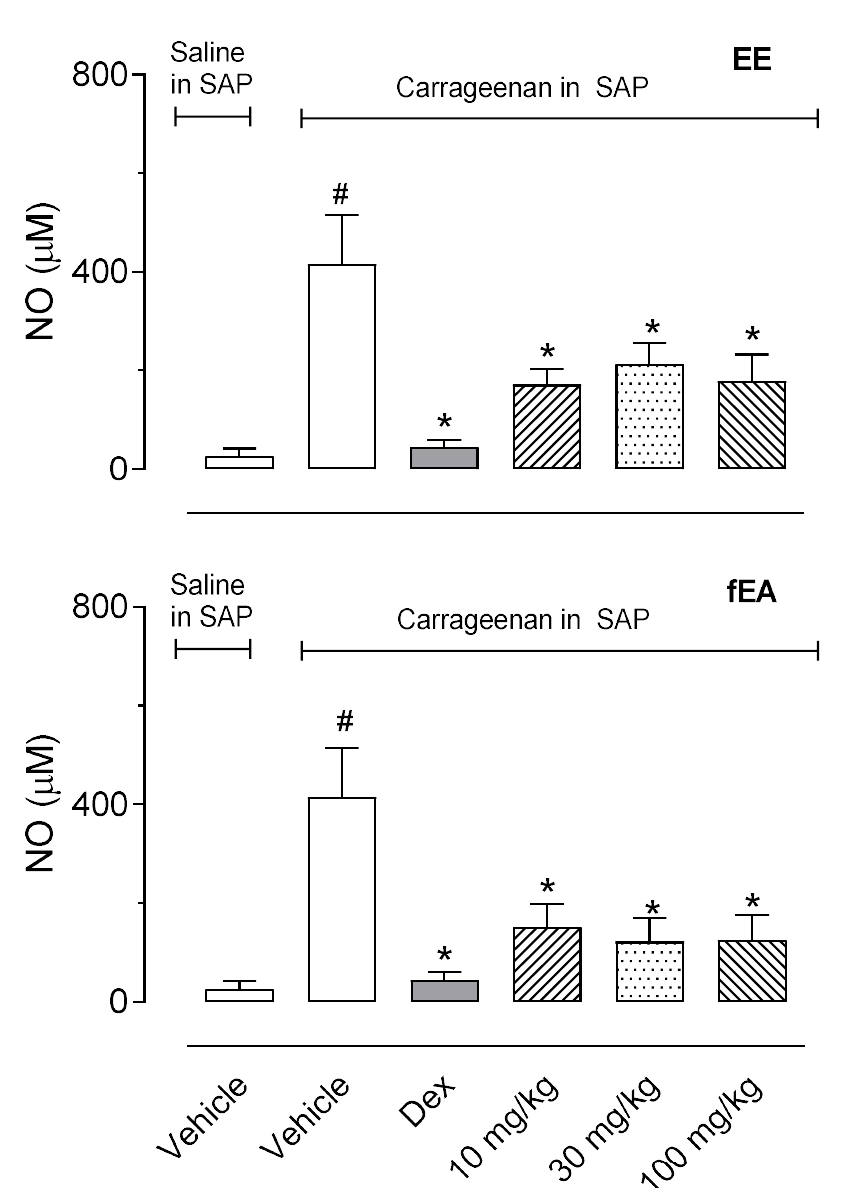
Figure 6. Effect of the ethanol extract (EE) and fraction in ethyl acetate (fEA) from leaves of T. granulosa in nitric oxide (NO) accumulated in the exudate of SAP. The animals were pre-treated with vehicle, dexamethasone (Dex, 0.5 mg/kg, i.p.), EE or fEA (10, 30 or 100 mg/kg), 60 min before the injection of carrageenan (1%) or saline into the SAP. The results are presented as mean ± S.D. ( n = 7). The statistical significance was calculated comparing the groups pre-treated with EE, fEA or dexam- ethasone with the group pre-treated with the vehicle, using ANOVA followed by the post-test of Newman–Keuls. # p < 0.05 when comparing the vehicle-treated group receiving carrageenan in SAP with the vehicle-treated group that received saline in SAP; * p < 0.05 when comparing dex-, EE- or fEA-treated groups that received carrageenan in SAP with the vehicle-treated group receiving carrageenan in SAP.